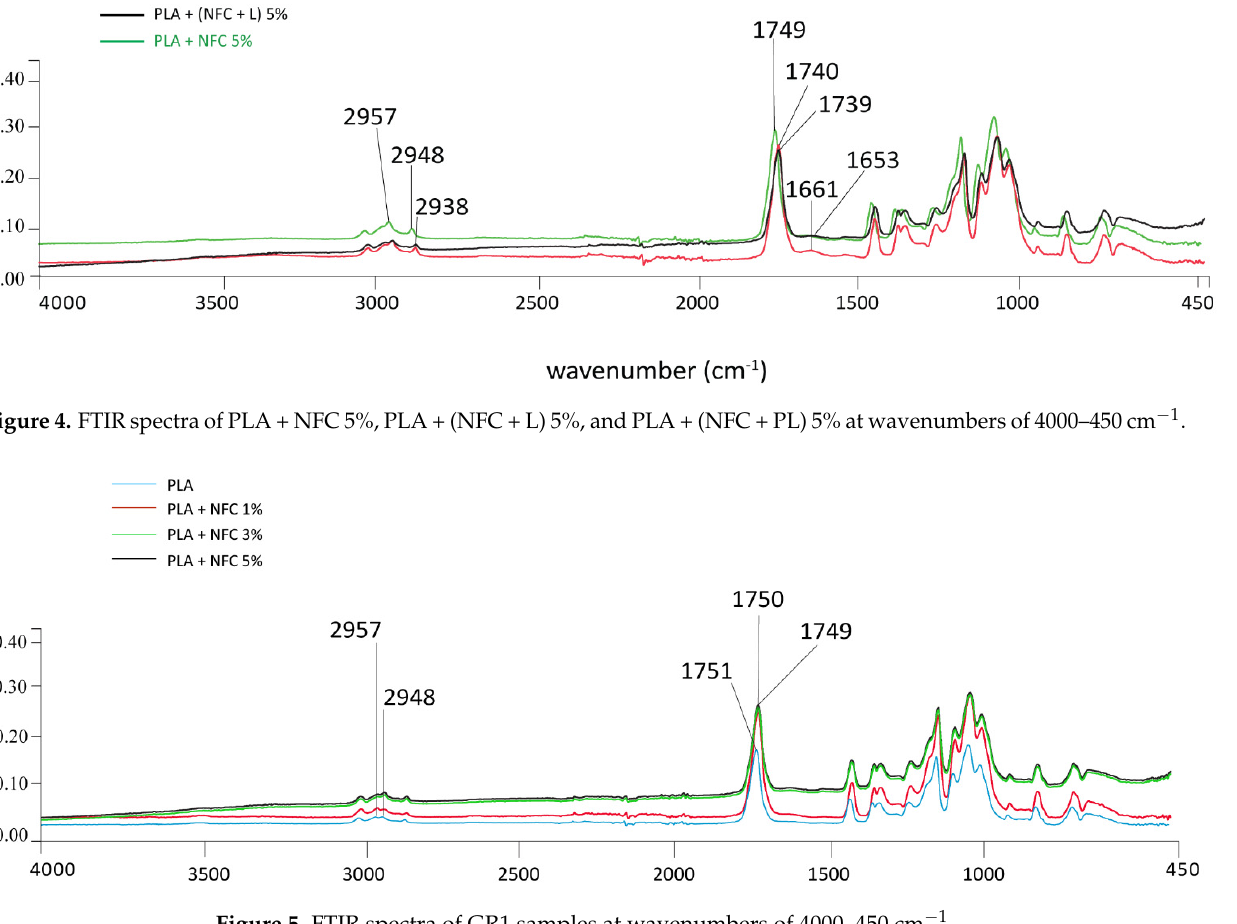
Figure 5. FTIR spectra of GR1 samples at wavenumbers of 4000–450 cm − 1 .